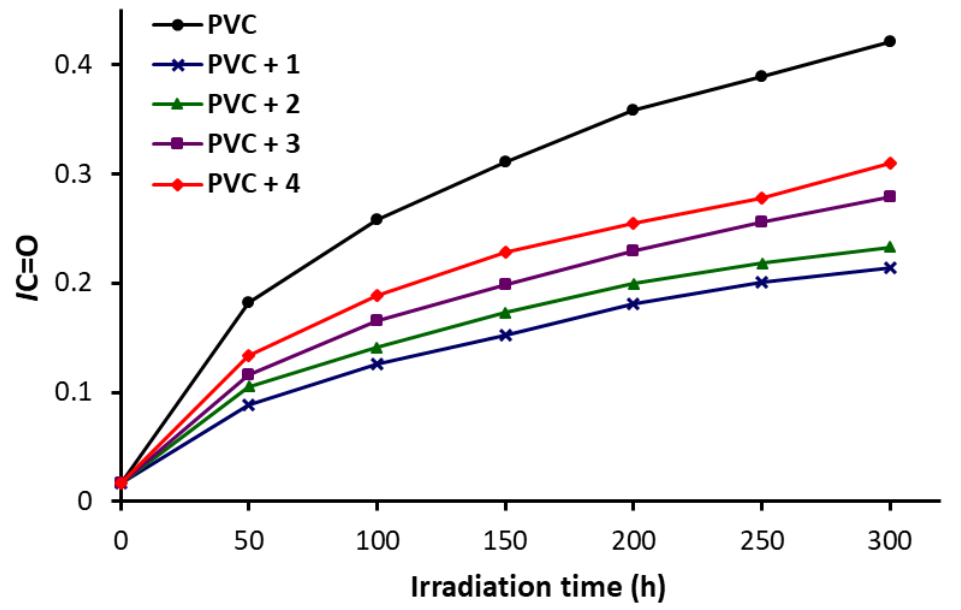
Figure 4. Effect of UV irradiation time on the I C=O of PVC films.